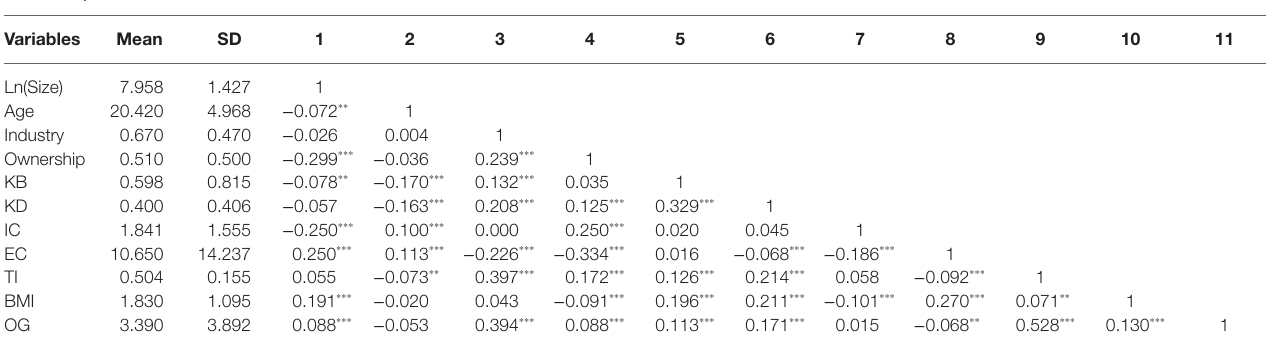
TABLE 2 | Means, SD, and correlation